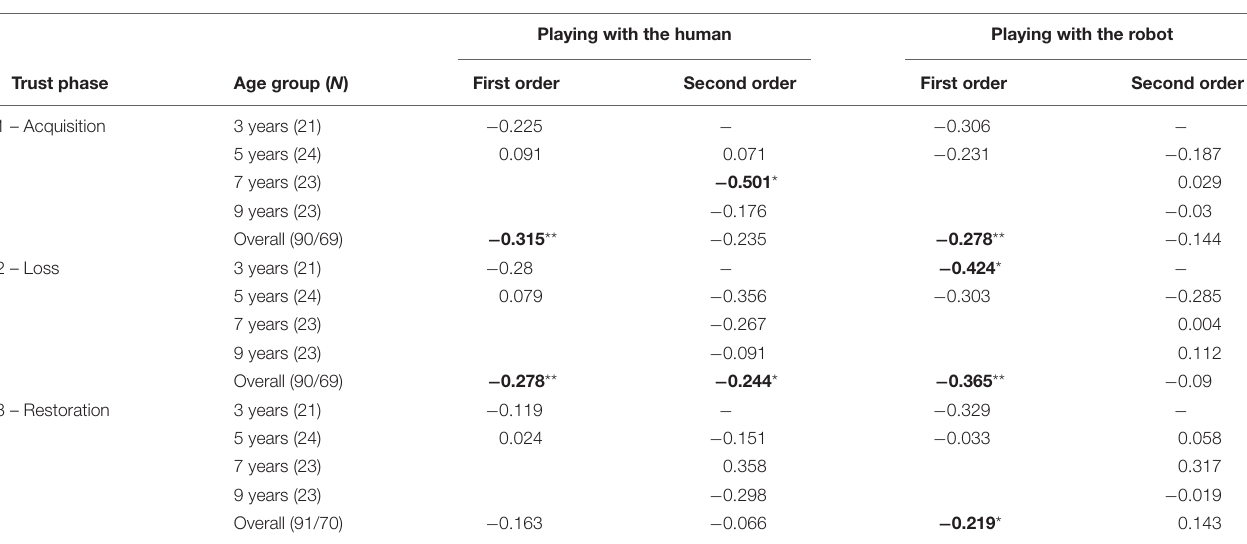
TABLE 3 | Association between Trust and ToM.